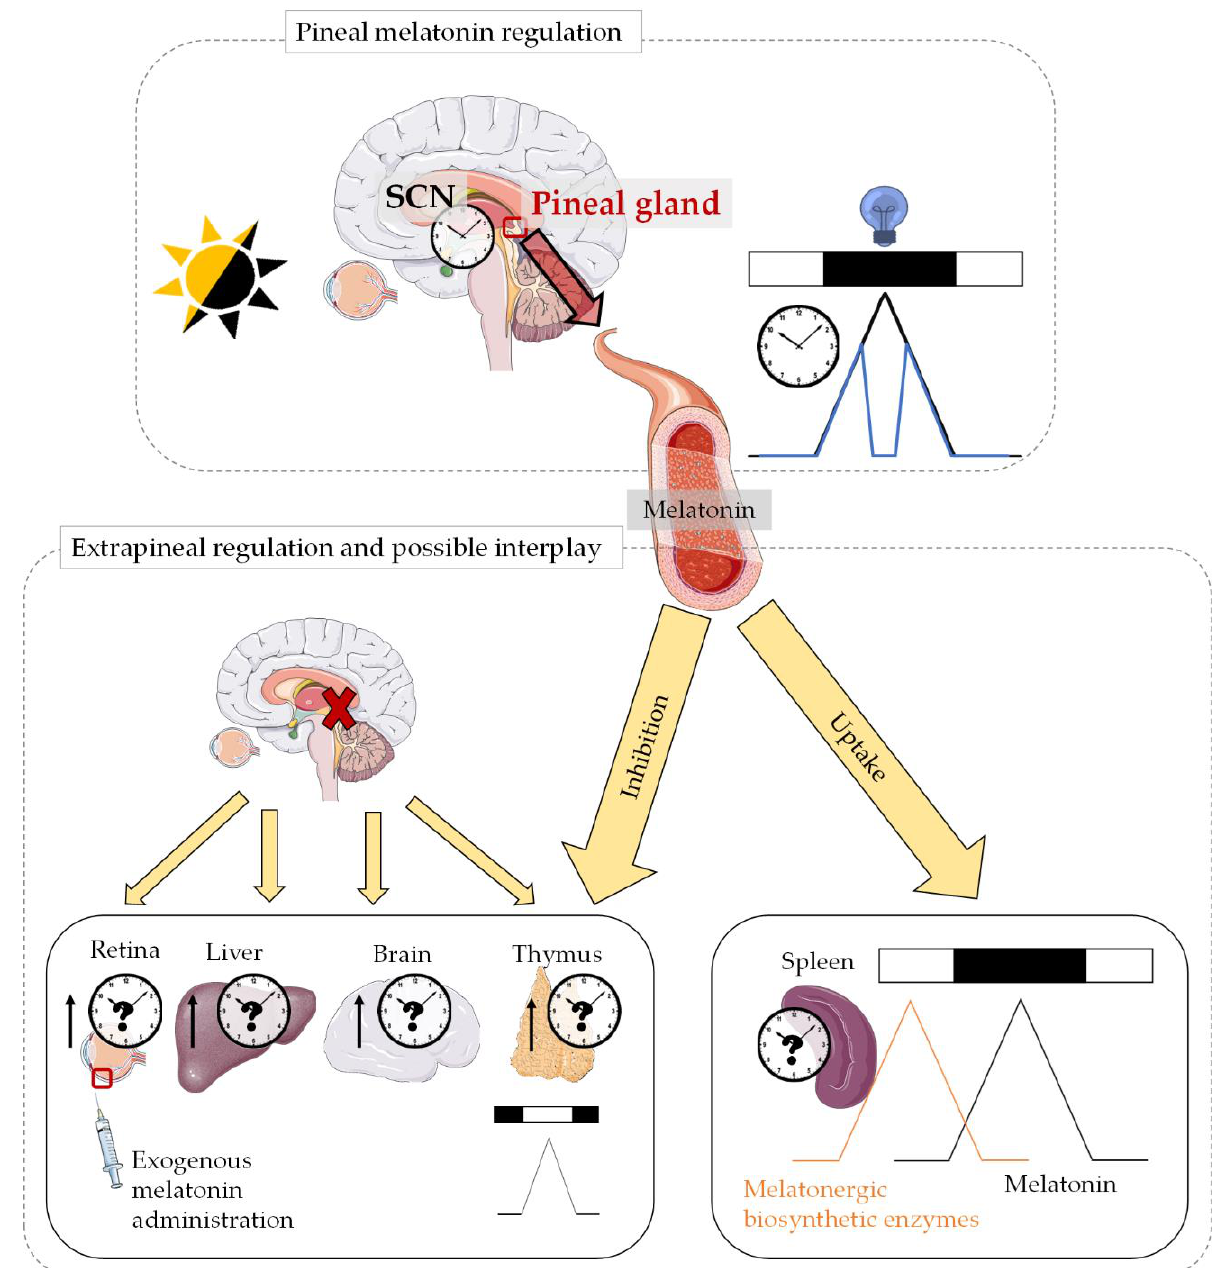
Figure 2. Regulation of pineal melatonin secretion ( top ) subjected to circadian rhythm originated in the suprachiasmatic nuclei (SCN), entrained by the light–dark cycle (peak at night), and also subjected to an acute suppression by light at night. Possible circadian regulation of extrapineal melatonin production ( bottom ) in the retina, liver, brain, thymus, and spleen. A possible interplay with pineal melatonin has been suggested (yellow arrows). Retina is able to uptake melatonin from exogenous administration, while pineal melatonin seems to inhibit its local production, since pinealectomy increases local melatonin levels as well as those in the liver, brain, and thymus. In addition, in the thymus the local melatonin content peaks during the day, which confirms the possible local inhibition by pineal melatonin. The spleen exhibits a peak of melatonin levels during the night, while the melatonergic biosynthetic enzymes are mainly expressed during the day, indicating a possible uptake of melatonin from circulation. Further studies are needed to fully understand this relationship. Cross on the pineal gland means pinealectomy. ↑ means increased local melatonin levels. This figure was built with SMART resources (Servier Medical Art), licensed under a Creative Common Attribution 3.0 Generic License. See http://smart.servier.com/.